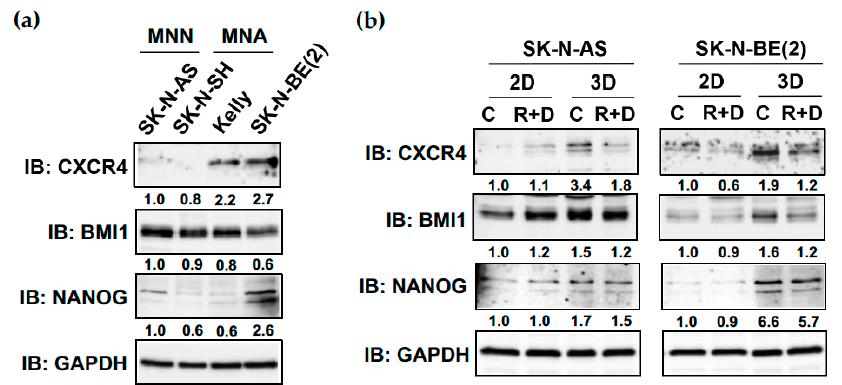
Figure 7. The R+D ‘pre-treatment’ reduces CXCR4, BMI1 and NANOG protein expression in NB spheroid cultures. Immunoblot (IB) analysis showing ( a ) CXCR4, BMI1 and NANOG protein expression in four different neuroblastoma cell lines grown in 2D cultures with medium supplemented with 10% FBS, and ( b ) CXCR4, BMI1 and NANOG protein expression under control (C)- and Rapamycin plus Dasatinib (R+D)-treated conditions comparing 2D and 3D cultures grown in medium supplemented with 5% KOSR. GAPDH was applied as loading control. Numbers below bands state protein expression normalized to GAPDH. C: Vehicle-treated control cells. R+D: Rapamycin plus Dasatinib treatment as depicted in Table 2. MycN-non-amplified (MNN), MycN-amplified (MNA). IB: Immunoblot. Original immunoblot (IB) images (Figure S4).